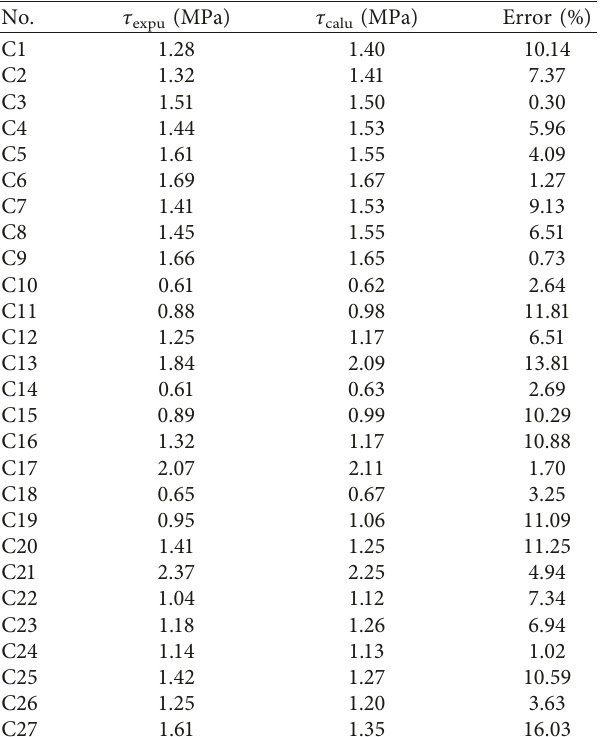
Table 4: Summary of the calculated and the experimental bond strength. No.